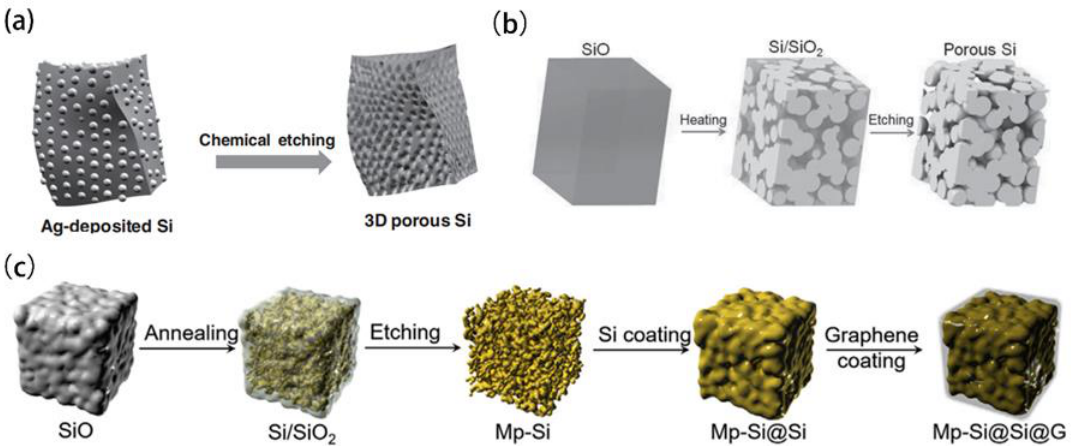
Figure 9. ( a ) Schematic illustration of the preparation process of porous Si by etching Ag template [62]. ( b ) Schematic illustration of the preparation process of porous Si by disproportionation reaction of SiO [67]. ( c ) Schematic illustration of the preparation process of Mp-Si@Si@G sample [68]. Reprinted with permission from [62]. Copyright 2012 John Wiley and Sons. Reprinted with permission from [67]. Copyright 2012 John Wiley and Sons. Reprinted with permission from [68]. Copyright 2019 Elsevier.